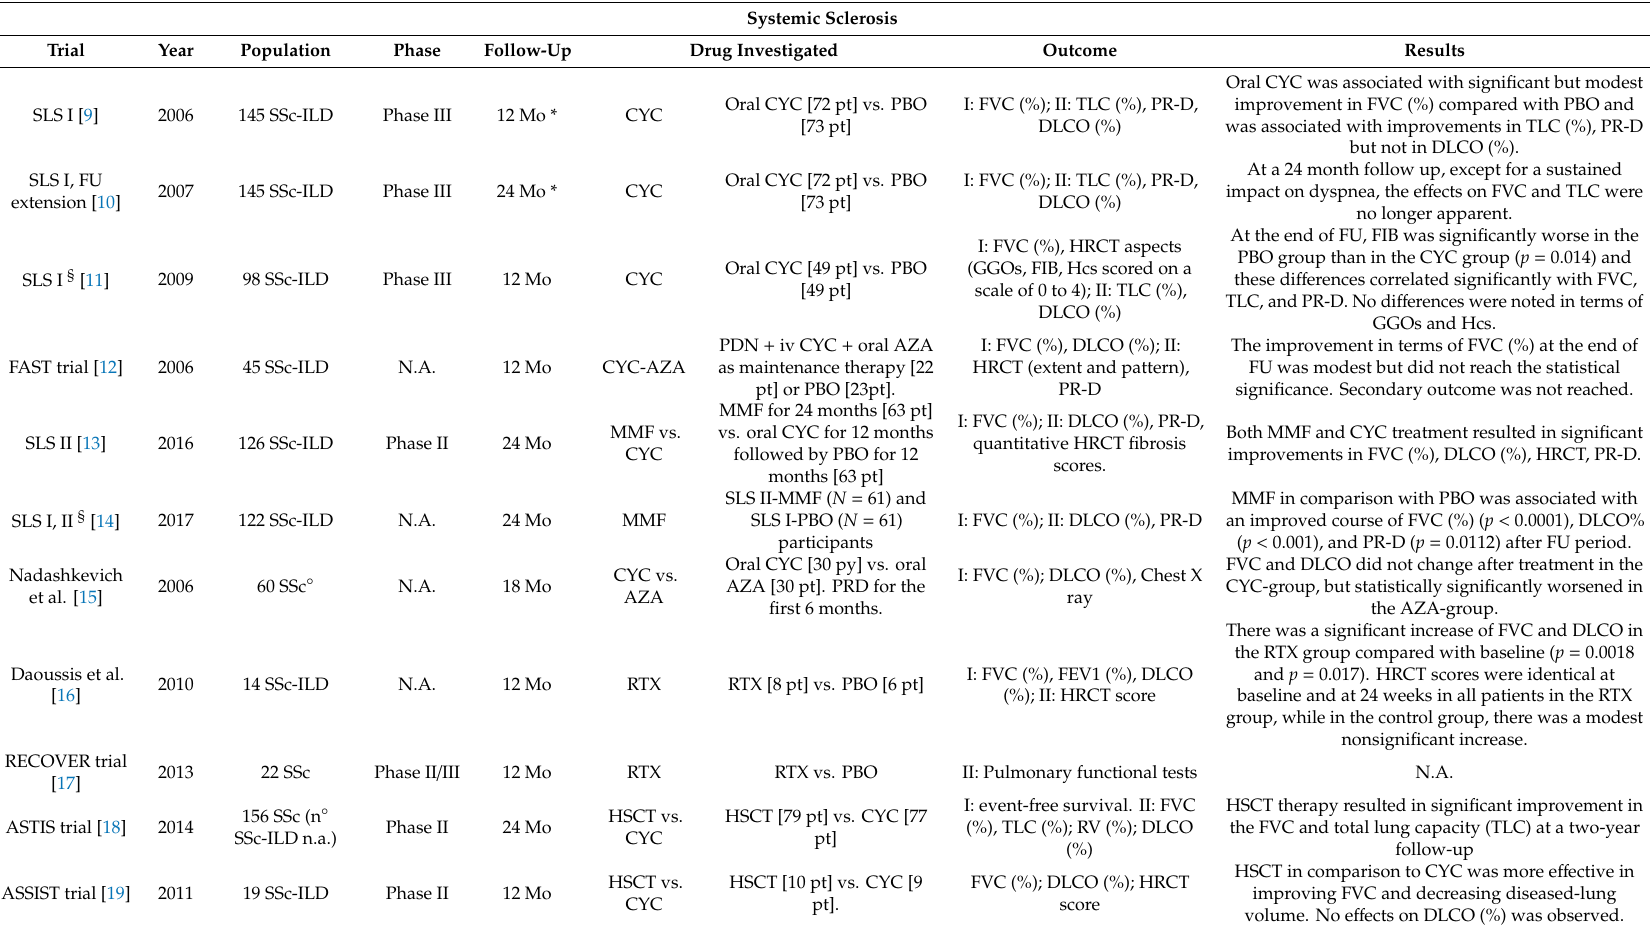
Table 1. Treatment of interstitial lung disease in connective tissue